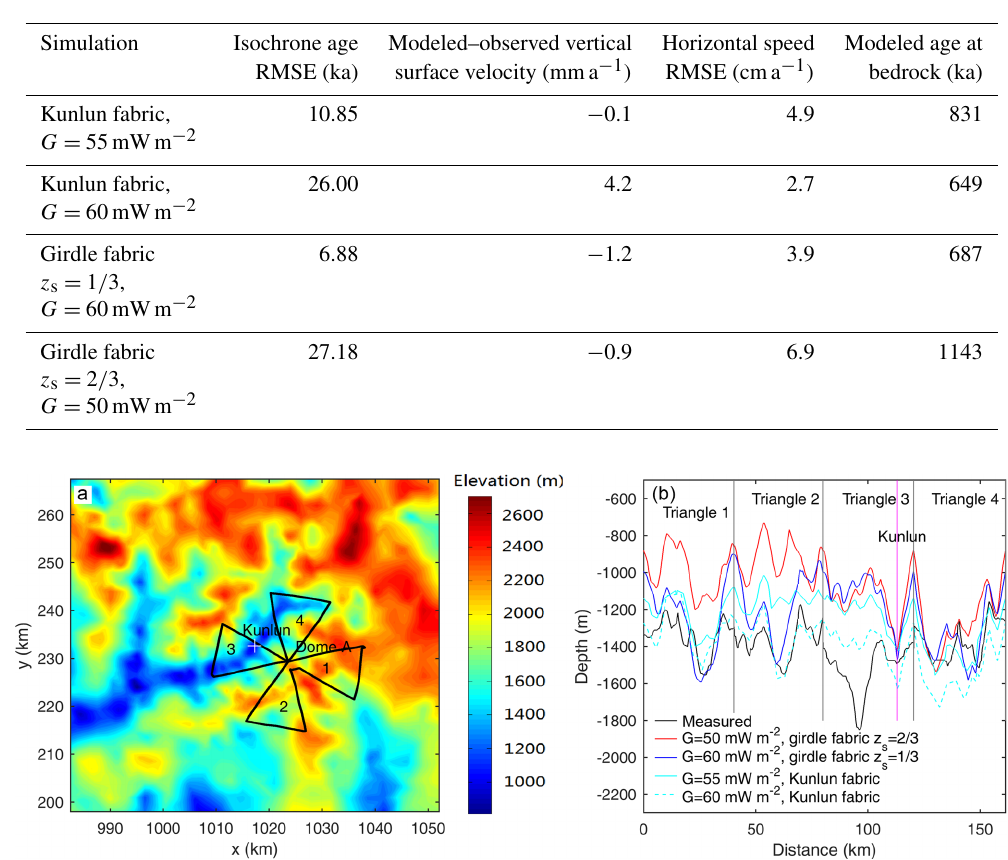
Table 1. Modeled and observed isochrone ages and surface velocities at Kunlun.